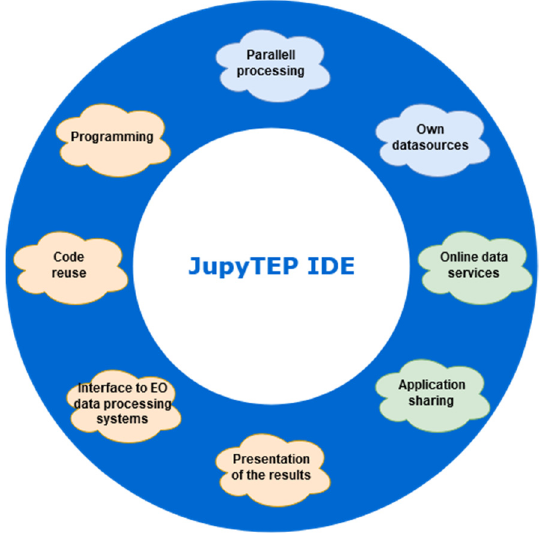
Figure 2. JupyTEP IDE the idea of processing integration.